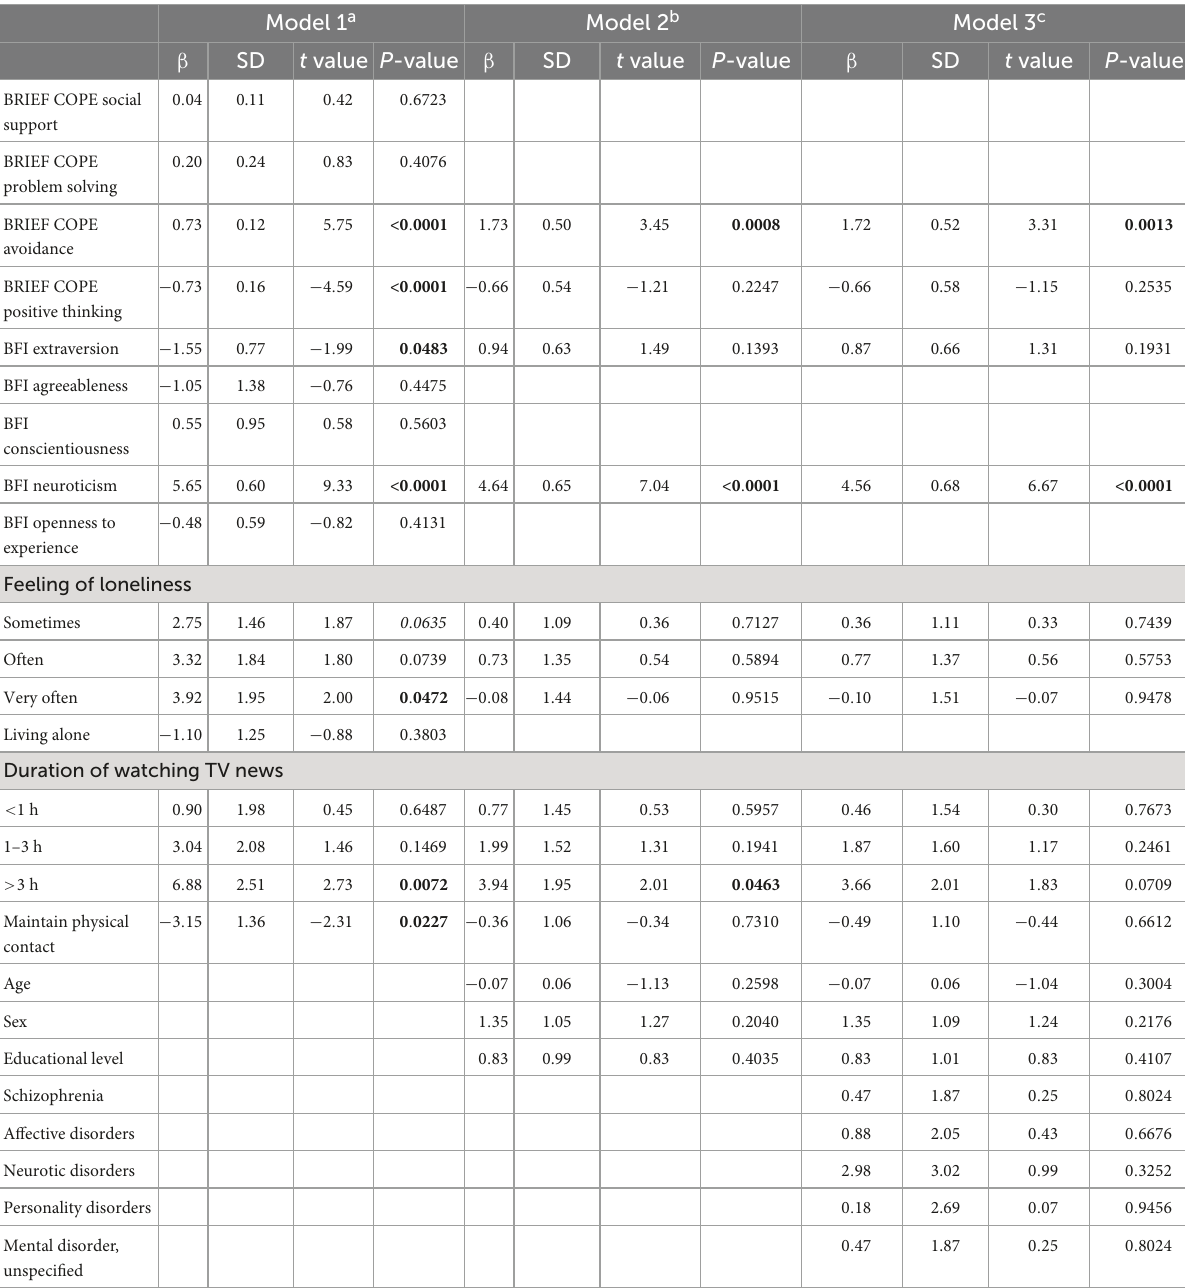
TABLE 2 Parameter estimates of the linear regression models for general anxiety